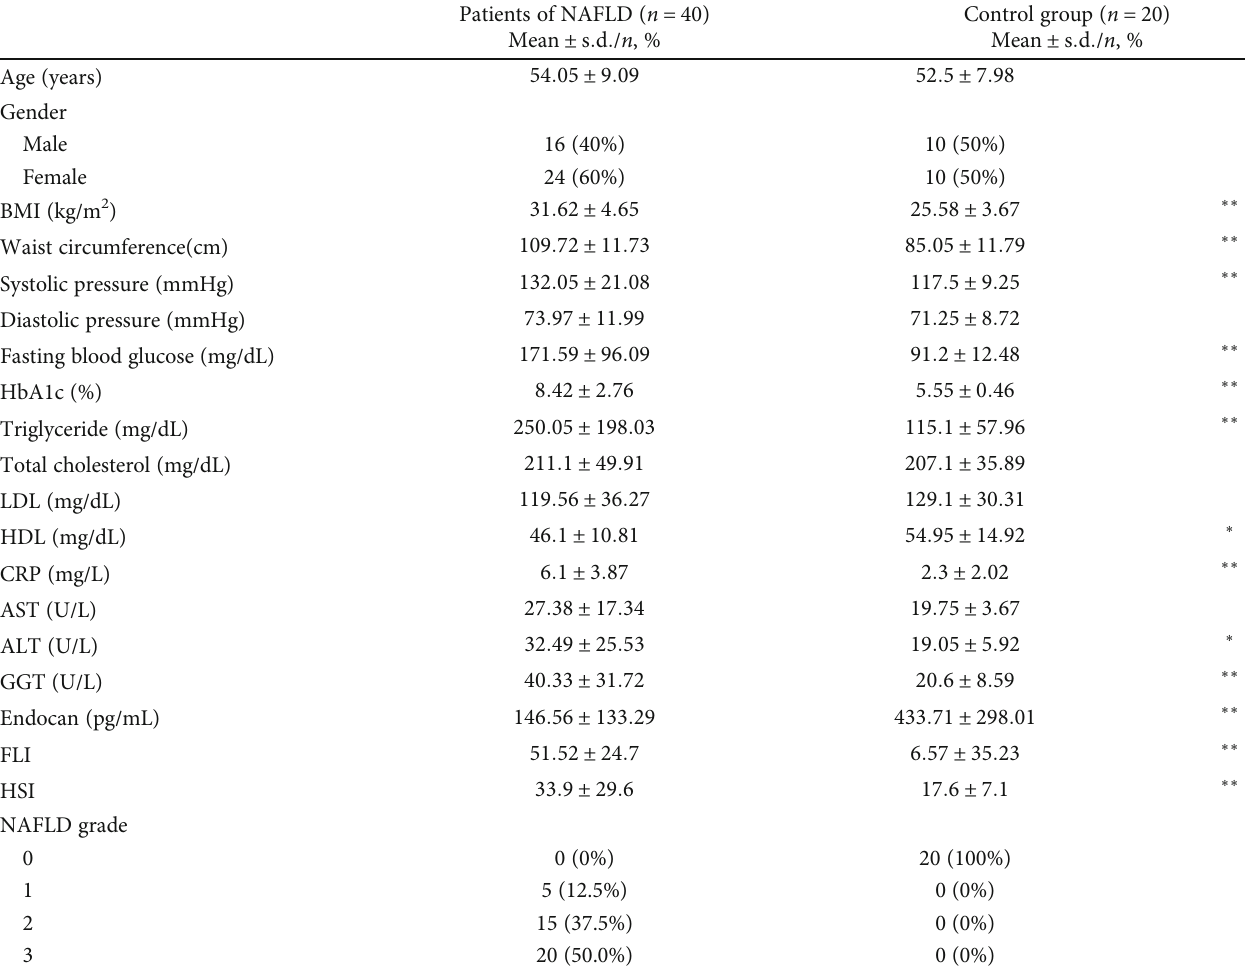
Table 1: Clinical and laboratory characteristics of controls and patients of NAFLD. Patients of NAFLD ( n = 40